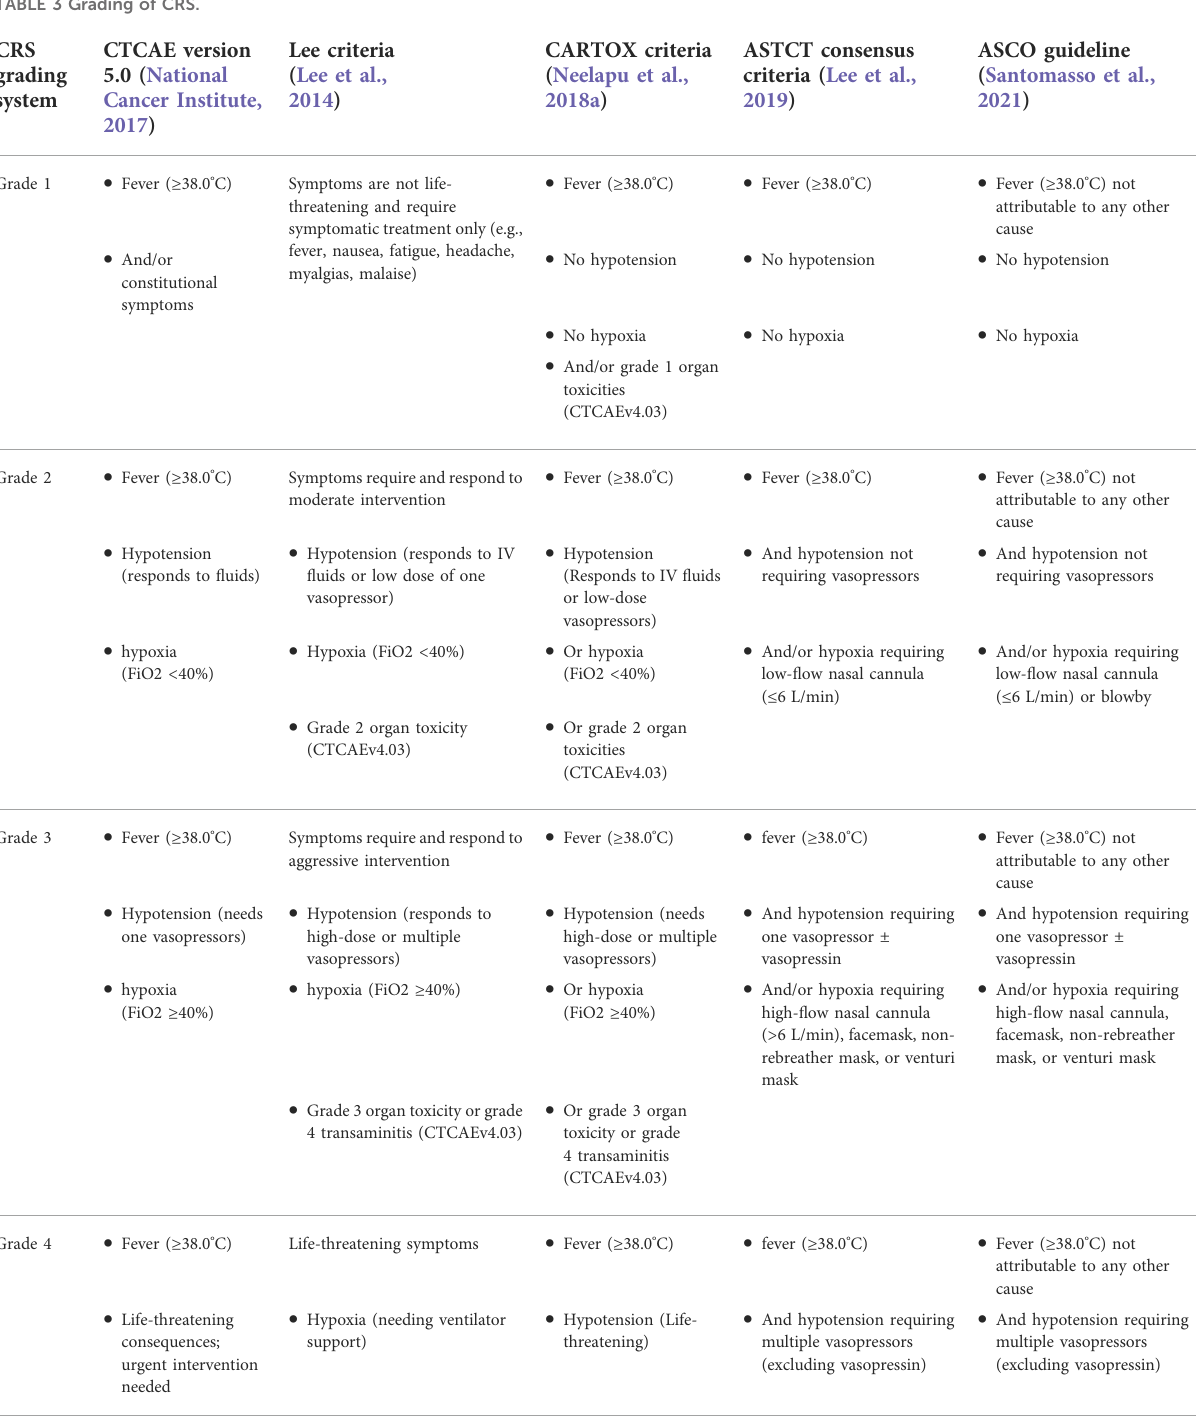
TABLE 3 Grading of